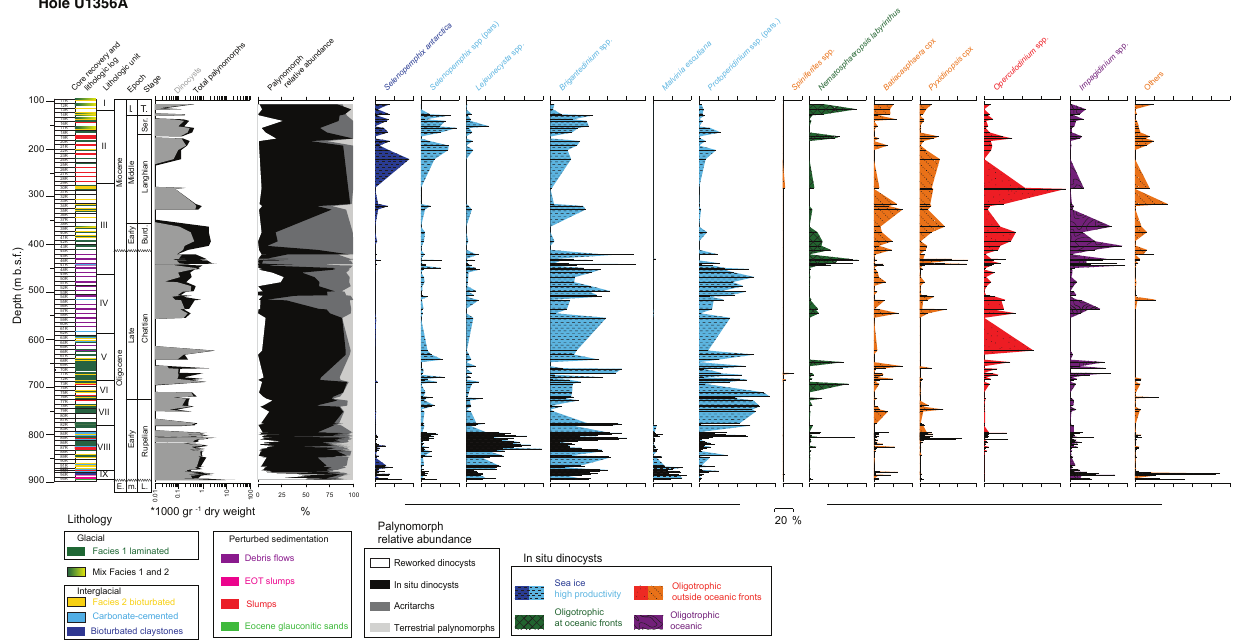
Figure 4. Core recovery, lithostratigraphic facies (after Salabarnada et al., 2018, and Sangiorgi et al., 2018), lithologic units (Escutia et al., 2011), chronostratigraphic epochs (E: Eocene) and stages (L: Lutetian; Burd.: Burdigalian; Ser.: Serravallian; T.: Tortonian), absolute palynomorph (grey) and in situ dinocyst (black) concentrations (number per gram of dry sediment, presented on a logarithmic scale), paly- nomorph content (reworked dinocysts, in situ dinocysts, acritarchs, terrestrial palynomorphs (given in percentages of total palynomorphs), and relative abundance of in situ dinocyst eco-groups (in percent of in situ dinocysts) for the Oligocene–Miocene of Hole U1356A.